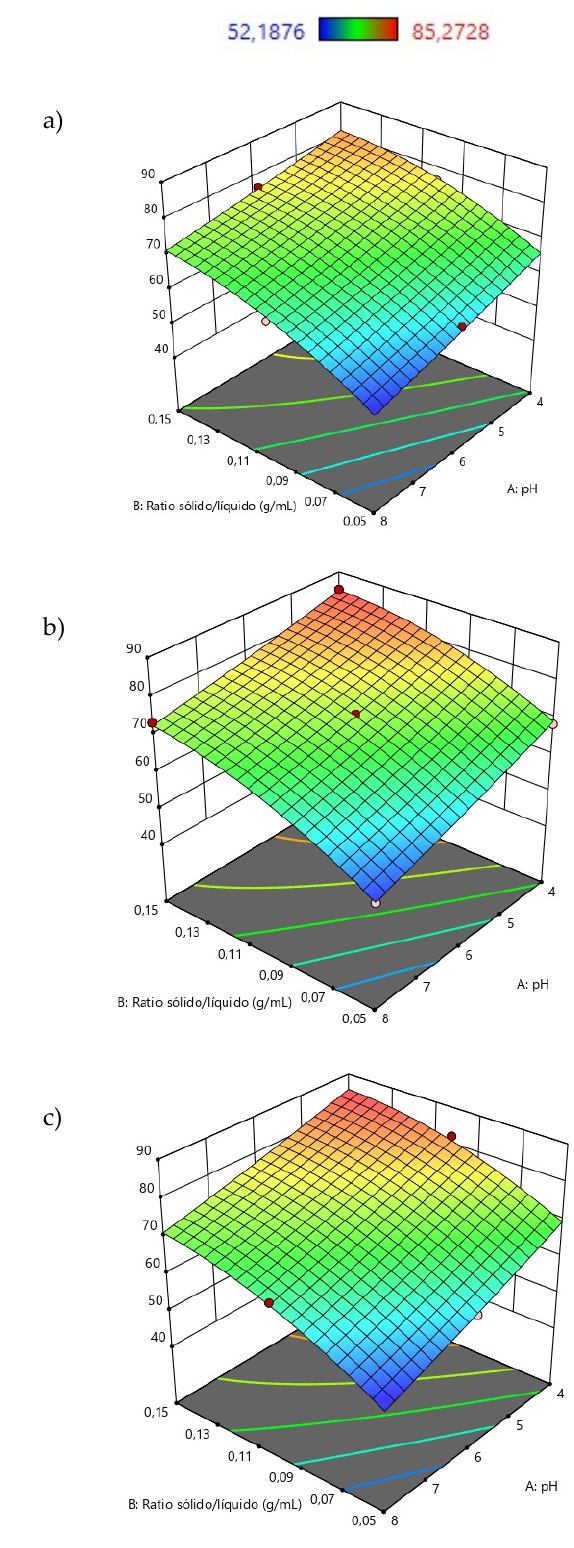
Figure 2. Lactic acid removal as an interaction between the solid/liquid ratio ( x 2 ) and pH ( x 1 ) setting time ( x 3 ) at ( a ) 1 h, ( b ) 5 h and ( c ) 9 h for A100 resin. For a tertiary resin (A100), described for simplicity reasons as P-R 2 N, where P is the polystyrene divinyl benzene structure and R are the alkyl chains of the tertiary amine group of the resin, the extraction of lactic acid (HL) could be described by a combination